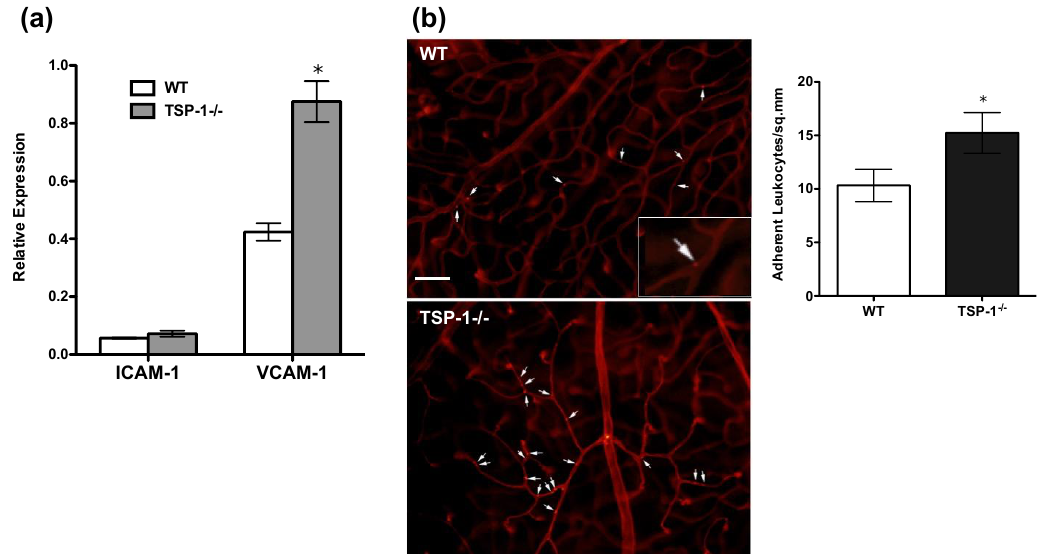
Figure 3. The expression of VCAM-1 and adherence of leukocytes is increased in TSP-1-deficient blood vessels in the retina. ( a ) Real-time PCR was performed on RNA isolated from retinas harvested from WT or TSP-1-deficient (TSP-1 − / − ) mice (8 weeks old, n = 5 each group) to detect message levels for ICAM-1 and VCAM-1 genes. Results are expressed as the mean ± SEM. ( b ) Firmly adherent leukocytes in retinal vessels were visualized by perfusing mice with rhodamine-conjugated Con A (red) before harvesting retina. Representative images of retina whole mounts from WT and TSP-1-deficient mice are shown with a quantitative assessment of adherent leukocytes in retinal vessels ( n = 4 each group). White arrows indicate adherent leukocytes in the main images, and the inset shows a digital magnification of an area. Data are expressed as the mean number of leukocytes per mm 2 ± SEM. * p < 0.05. Scale bar = 75 µM.